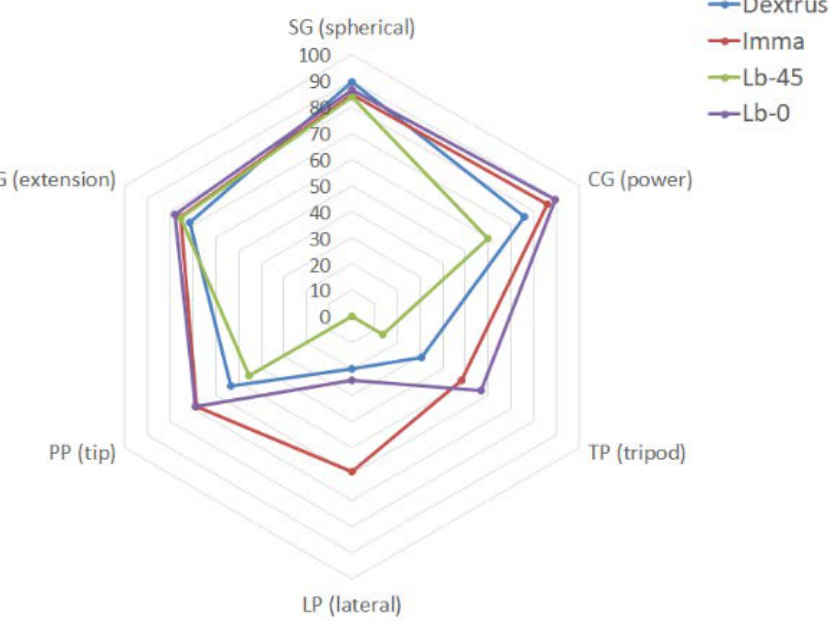
Figure 10. Left, Ts scores across the various prehensile patterns of the SHAP; right, AHAP’s pGAS for those same patterns.